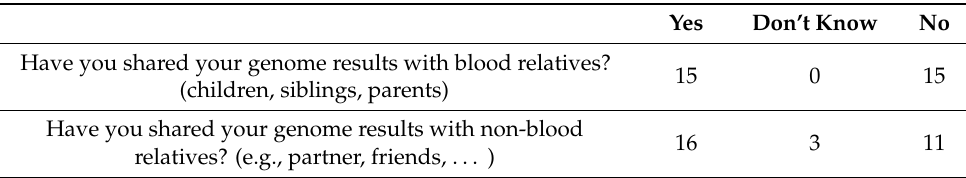
Table 9. Respondents on sharing genomic results with different parties after receiving results (post, n =